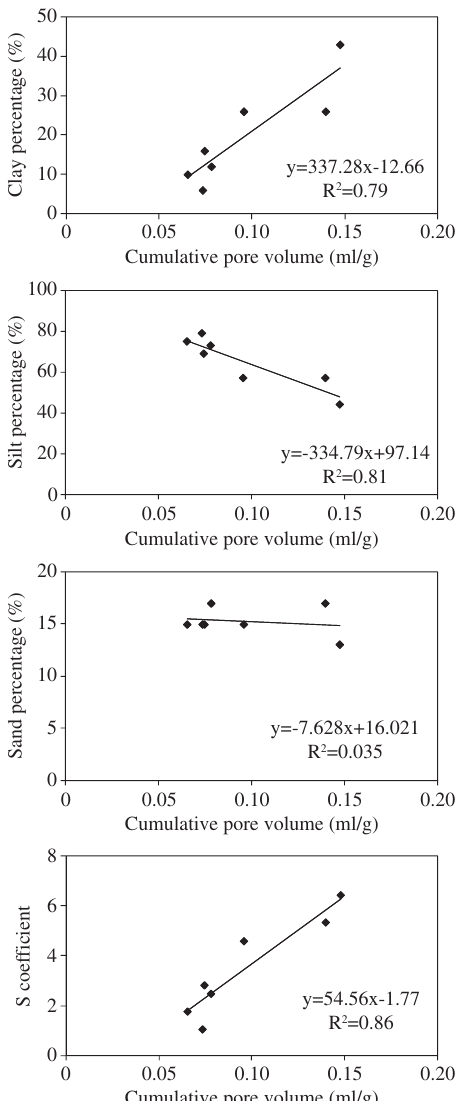
Figure 12 Relations between cumulative pore volume and clay, silt, and sand percentage and S coefficient.